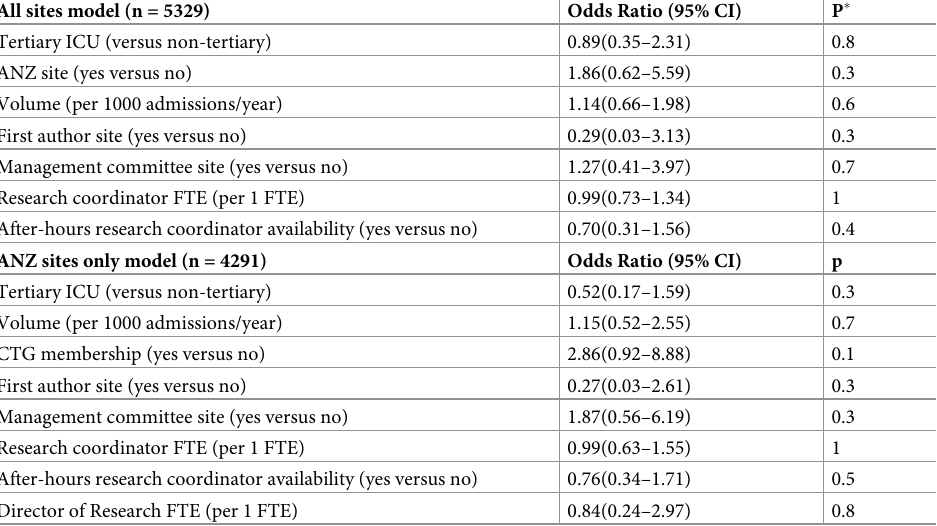
Table 2. Multivariable logistic regression for eligible patients being declined for randomization by clinicians in the ADRENAL trial. All sites model (n =